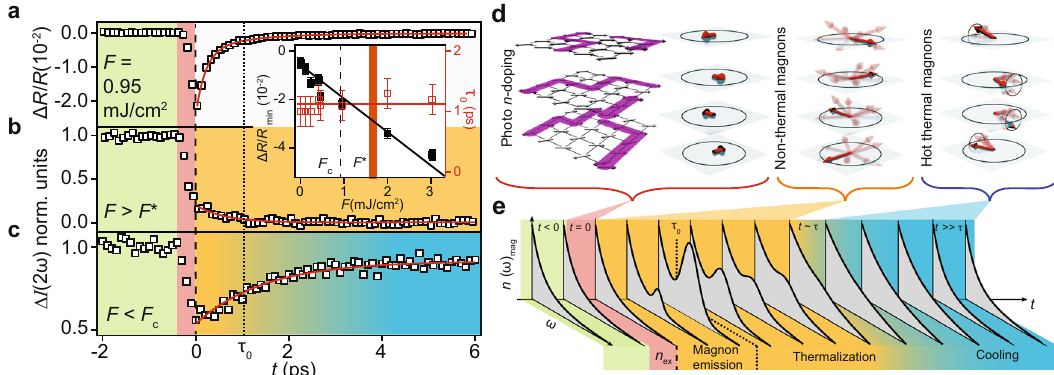
Fig. 4 Magnon population induced critical slowing down. Simultaneous measurements of the a transient re fl ectivity Δ R / R and b , c transient change in second harmonic generation (SHG) intensity Δ I (2 ω ) acquired under identical experimental conditions (except for fl uence) at T = 80K. Inset of panel a: fl uence dependence of the Δ R / R minimum (black markers) and characteristic recovery time τ 0 (red markers) extracted through double exponential fi ts (red curve) to the Δ R / R data (See “ Exponential fi tting procedure for linear re fl ectivity ” ). Red vertical error bars represent the uncertainty in τ 0 obtained from fi tting to the double exponential function. Black error bars represent the standard deviation of the Δ R / R minimum over six independent measurements. Solid lines are guides to the eye. The dashed line and orange bar mark the critical fl uence, F c , and the fl uence at which the relaxation time diverges, F * , respectively. d Schematic of the complete temporal evolution of the real space c -axis magnetic correlations. The generation and propagation of doublons (purple lines) induce a suppression of long-range antiferromagnetic order as illustrated by a reduction of the net moment (red arrows; circle represents the equilibrium value) and a decoupling between layers (blue planes). Moment fl uctuations occurring at later stages in time are captured by semi-transparent red arrows. e Schematic of the temporal evolution of the magnon distribution function n ω ð Þ versus energy ω following pump excitation. Background colors denote different stages of temporal evolution as labeled in the fi gure. Over the time window 0< t ≲ τ (shaded orange), n ω ð Þ departs from Bose – Einstein